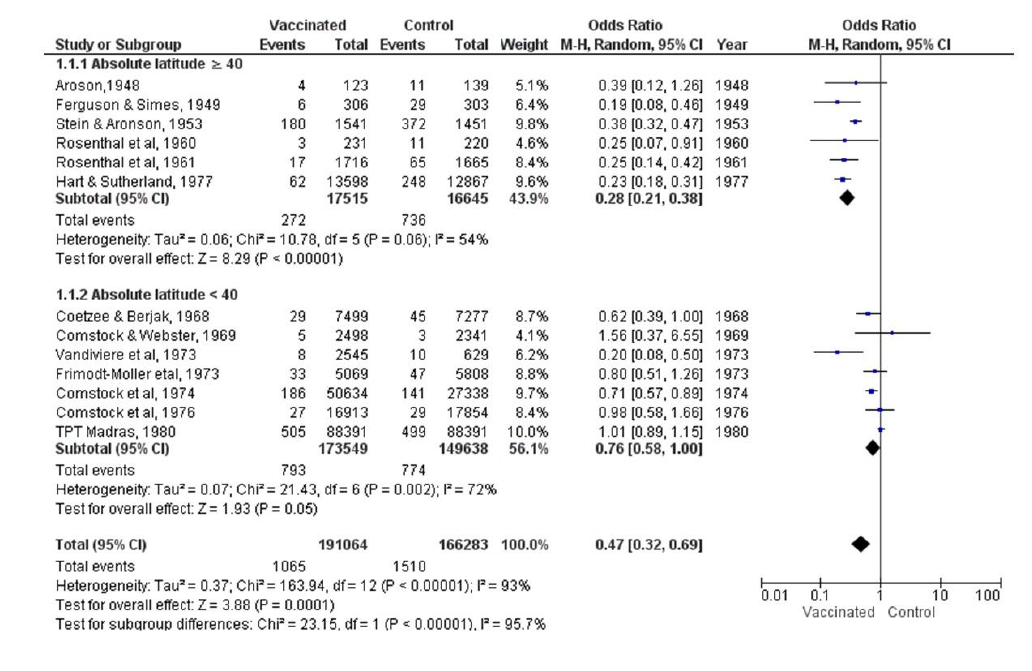
Figure 2. Fixed-effects Funnel Plot of Trial Studies by